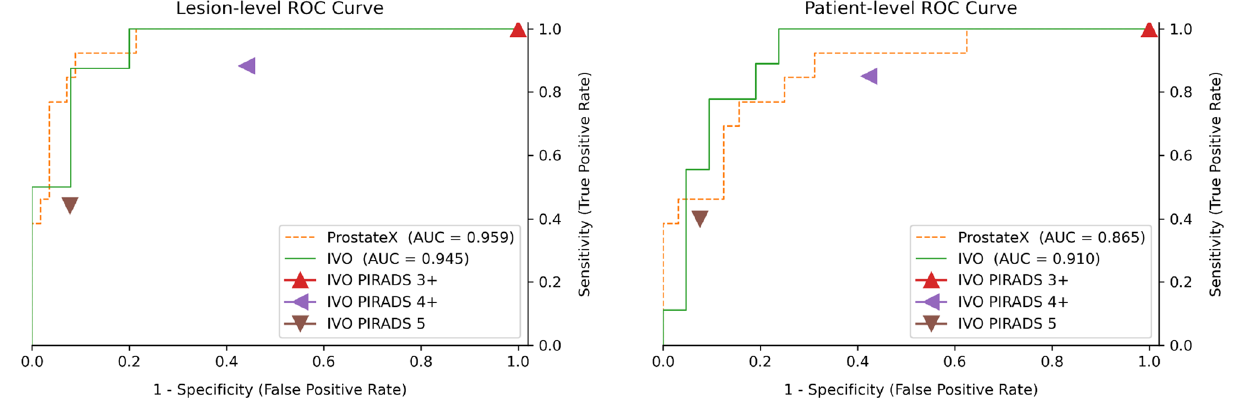
Figure 1. ROC curve of the model for significance criterion Gleason Grade Group ≥ 2, evaluated at the lesion level (left) and the patient level (right). For comparison, triangular marks represent the radiologist-assigned pre- biopsy PI-RADS. AUC: area under the ROC